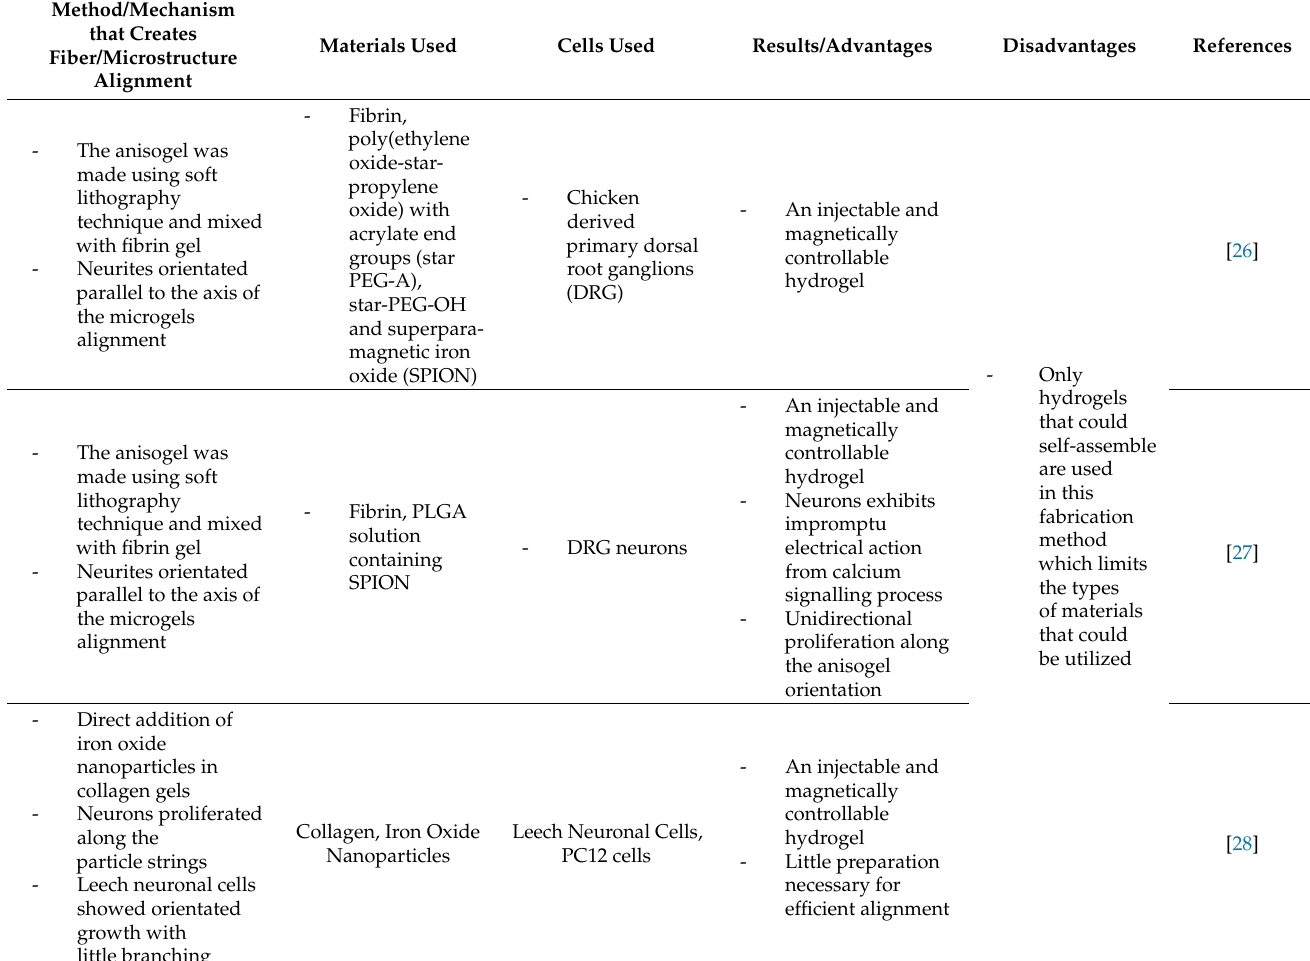
Table 4. Summary of magnetic orientation fabrication methods to produce scaffolds for